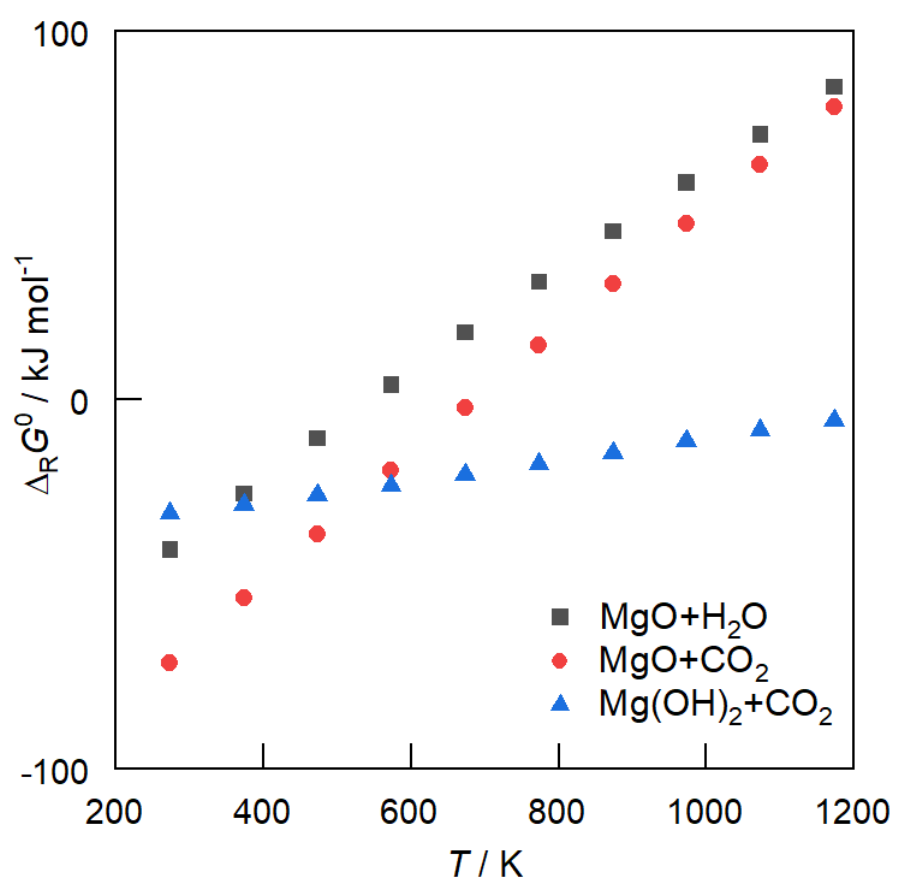
Figure Figure 4. Standard free enthalpies of reaction Δ R G 0 for the reaction of CO 2 with MgO (MgO + CO 2 ⇋ MgCO 3 ) and Mg(OH) 2 (Mg(OH) 2 + CO 2 (MgO + H 2 O ⇋ Mg(OH) 2 ) in a temperature range of 300 to 1200 K at ambient pressure; calculated with HSC Chemistry 8.